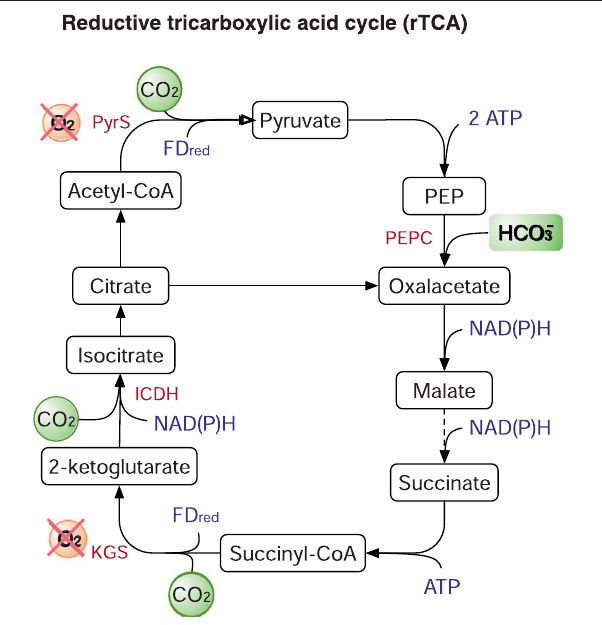
FIGURE 4 | The reductive tricarboxylic acid (rTCA) cycle. Enzymes: PyrS, pyruvate synthase; PEPC, PEP carboxylase; KGS, α